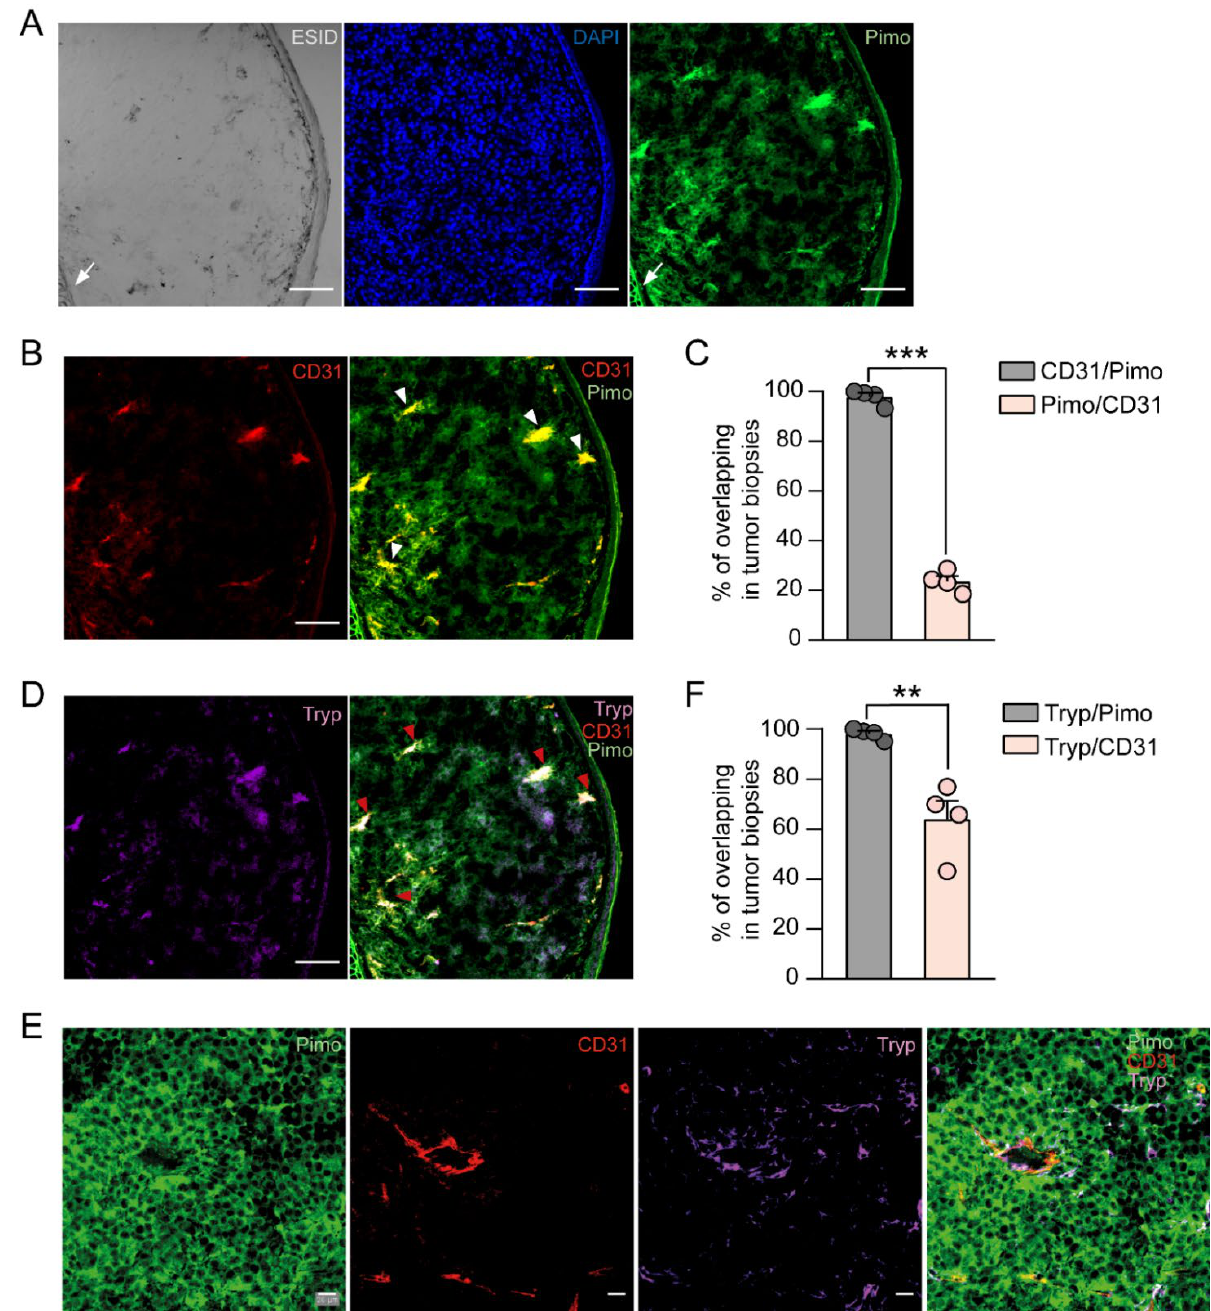
Figure 1. MCs are located in zones subjected to cyclic hypoxia within murine B16 melanoma tumors. Three to four weeks after inoculation of B16-F1 cells on mouse ear pinna, tumors were excised and processed as described in the Materials and Methods section. Thirty μm-thick slices were stained with specific antibodies against pimonidazole (Pimo), the platelet endothelial cell adhesion molecule (CD31), and tryptase (Tryp). ( A ) Representative ESID confocal image showing typical pinna morphology and the tumor mass (the ear cartilage is indicated by a white arrow). Cell nuclei and hypoxic regions were detected using DAPI (blue) and antibodies against pimonidazole (Pimo, green), respectively. ( B ) Tumor vasculature stained with an anti-CD31 antibody (red) and hypoxic areas with Pimo (green), showing colocalization between both fluorescent dyes (white arrowheads). Scale bar, 100 μm; objective 10X. ( C ) Quantification of the overlap between CD31/Pimo and Pimo/CD31 fluorescent signals. ( D ) Representative confocal images of tumor -infiltrating MCs stained with an antibody against tryptase (Tryp, purple) and their colocalization with CD31 and Pimo-positive regions (red arrowheads). Scale bar, 100 μm; objective 10X. ( E ) Magnified confocal images showing a large blood vessel (CD31+, red) in the Pimo-positive regions that are surrounded